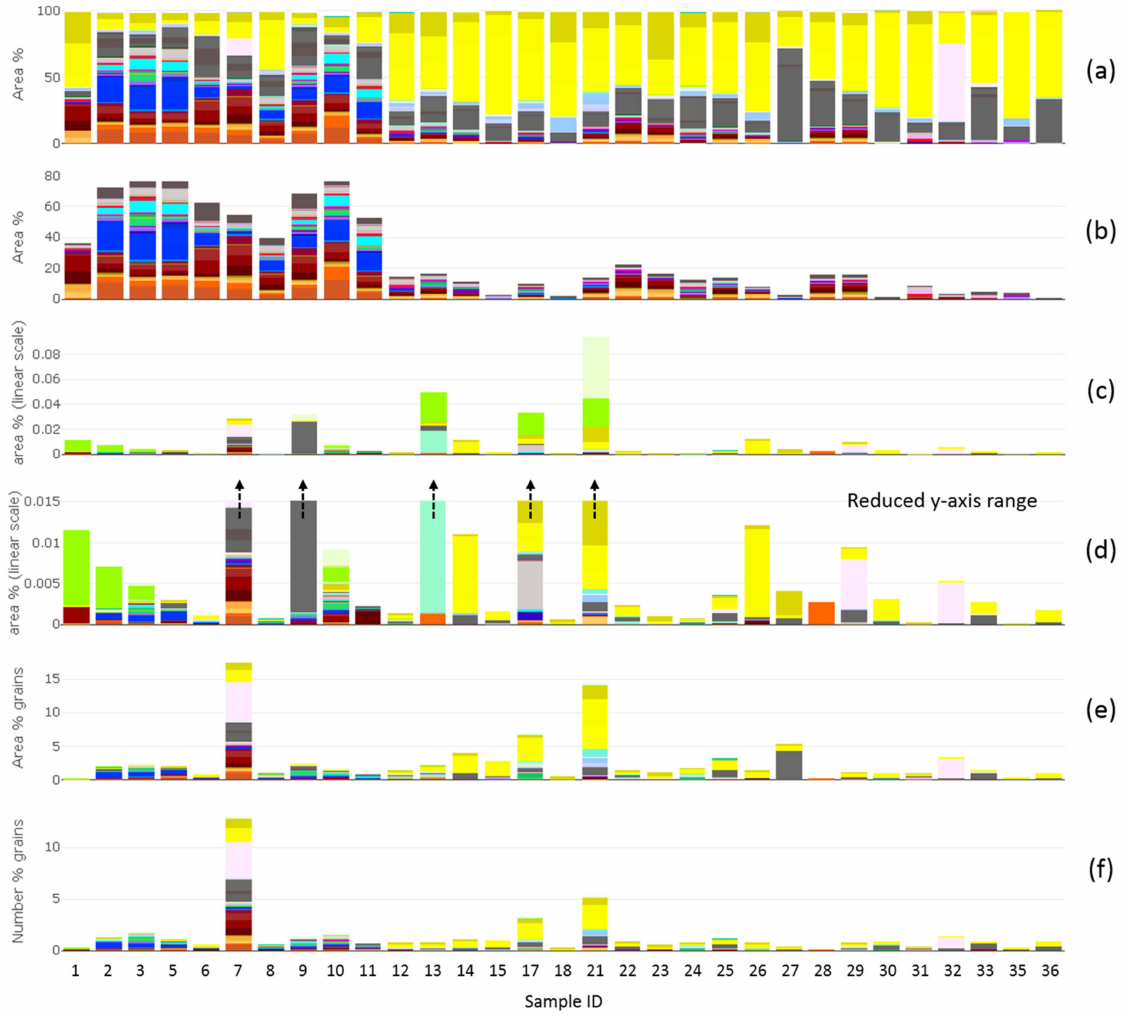
Figure 14. ( a ) Grain population abundances (all); ( b ) showing only unambiguously steelworks-related grain populations; ( c ) contributions of Pb-rich pixels from grain populations (as area % with respect to sample); ( d ) as ( c ) but with reduced y -axis range; ( e ) host grains as percentage of total grains in sample, by grain area; ( f ) as ( e ) but by number of grains. Colour scheme for grain populations as Figure